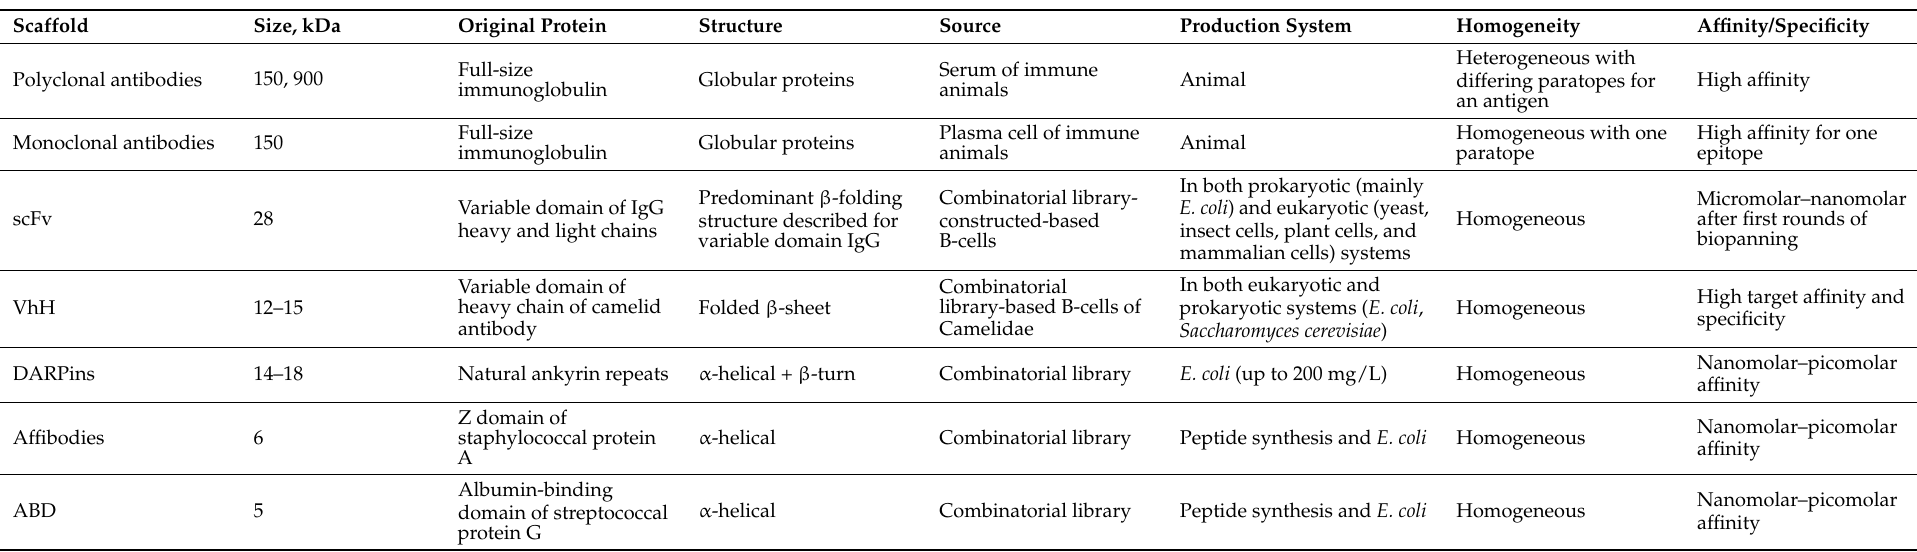
Table 1. Comparison of analyte-binding scaffolds in publications by Russian